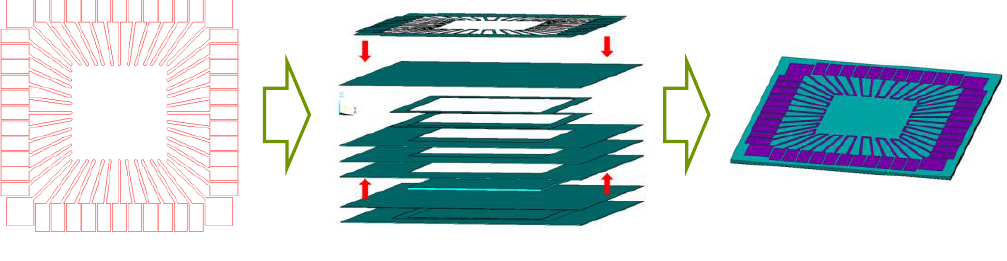
Figure 7. Application to a multilayer PWB case.